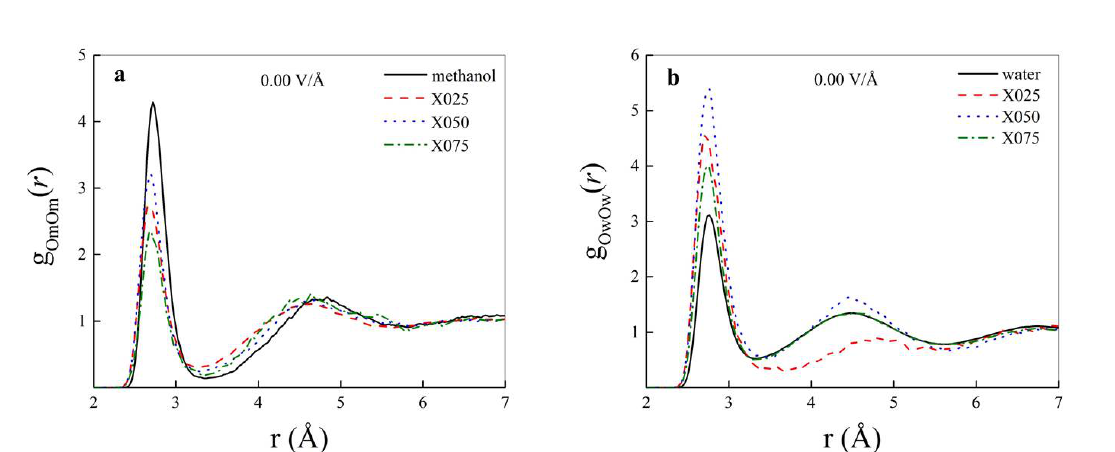
Figure 1. Methanol oxygen-methanol oxygen (O m O m ) ( a ) and water oxygen-water oxygen (O w O w ) ( b ) radial distribution functions (RDFs) in the zero-field regime in samples containing neat methanol ( a ) and neat water ( b ) (solid black curves), mixtures composed of 75:25 (dashed red curves), 50:50 (dotted blue curves), and 25:75 (dashed-dotted green curves) molar fractions of methanol and water molecules,